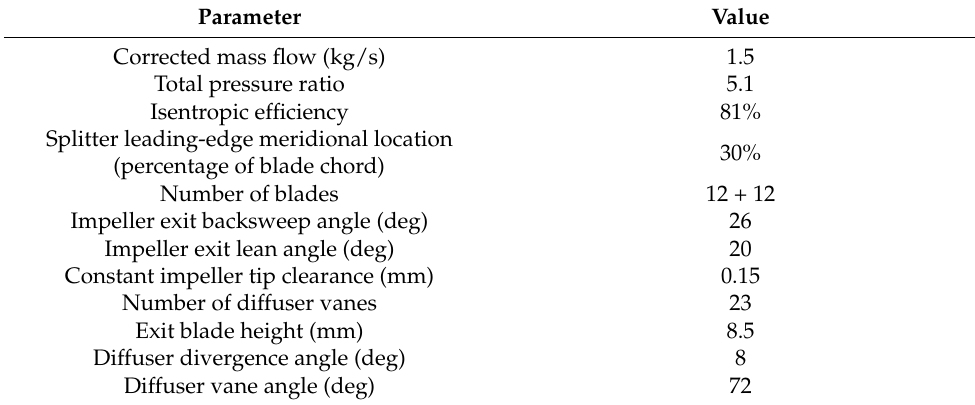
Table 1. Compressor-stage design